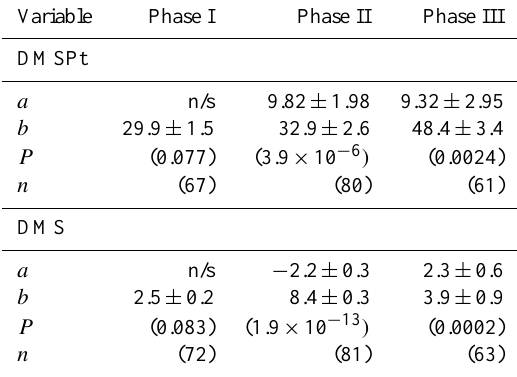
Fig. 2. Temporal progression of (A) DMSPt concentration and (B) DMS concentration in the three Low p CO 2 mesocosms (initial [H + ]: 0.5 to 0.7 × 10 − 8 EqL − 1 ; initial p CO 2 : 185 to 270µmolkg − 1 ) , three Medium p CO 2 mesocosms (initial [H + ]: 0.9 to 1.5 × 10 − 8 EqL − 1 ; p CO 2 : 375 to 685µmolkg − 1 ) and three High p CO 2 mesocosms (initial [H + ]: 1.8 to 3.1 × 10 − 8 EqL − 1 ; p CO 2 : 820 to 1420µmolkg − 1 ) . Bold lines represent the average value and the shaded area illustrates the range for the three meso- cosms. In order to illustrate the general patterns of change rather than daily variability, the lines are loess-smoothed fits to the data. The vertical lines mark the division into the three